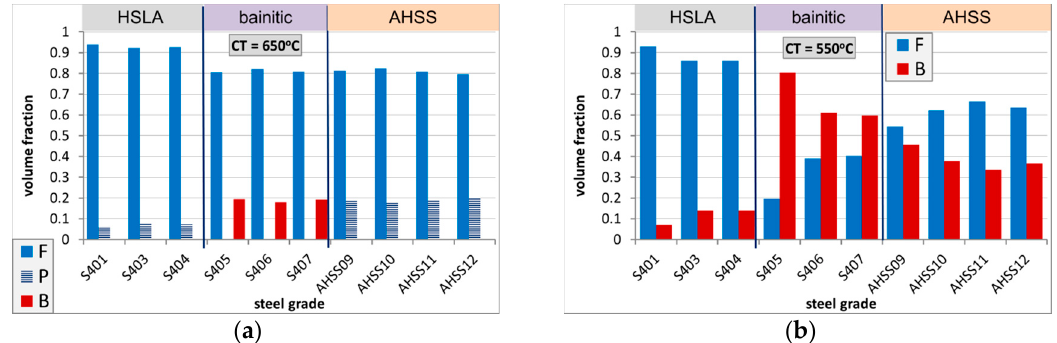
Figure 18. Phase composition of various steel grades after coiling at 650 °C ( a ) and 550 °C ( b ).